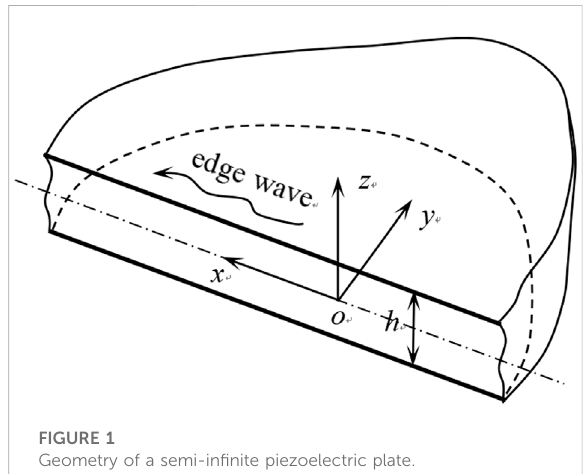
FIGURE 1 Geometry of a semi-in fi nite piezoelectric